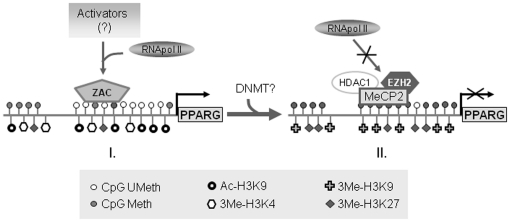
Schematic drawing of the proposed molecular mechanism(s) of PPARG silencing.(I) The unmethylated or partially methylated PPARG core promoter is activated by unknown transcriptional factors, among which only the zinc-finger protein ZAC that induces apoptosis and cell-cycle arrest has been identified. (II) Upon extensive promoter DNA methylation, MeCP2, HDAC1 and EZH2 containing repressive complexes are recruited to form a condensed chromatin structure, inhibiting RNA polymerase II and impairing gene transcription.